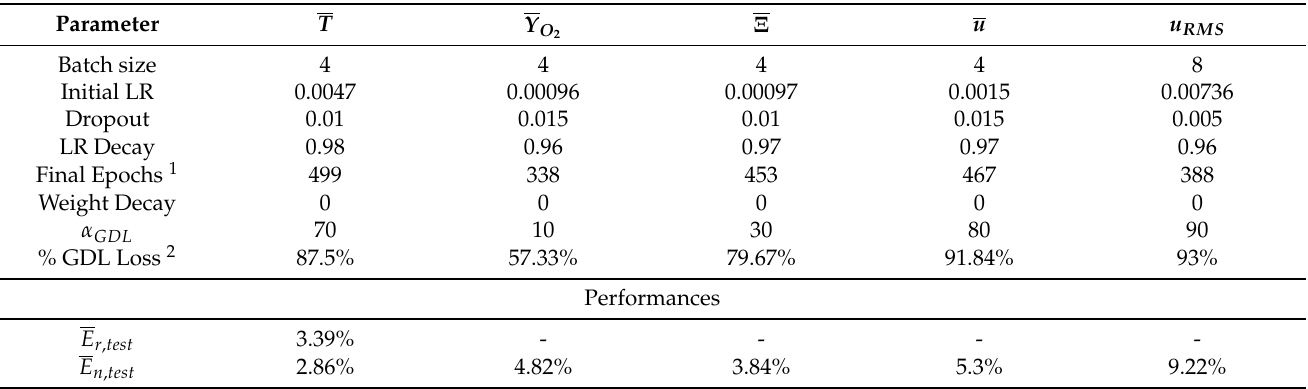
Table 5. Best-performing networks resulting from the Bayesian hyperparameters’ optimization. The parameters values and the networks performances over the test dataset (DS2) are